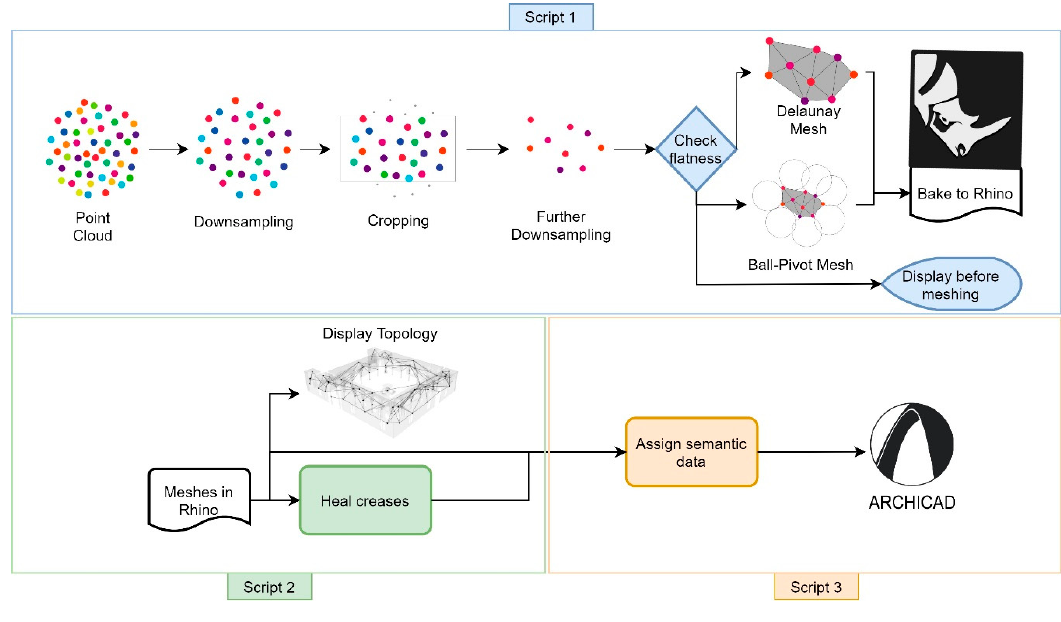
Figure 3. Automatic parametric workflow.